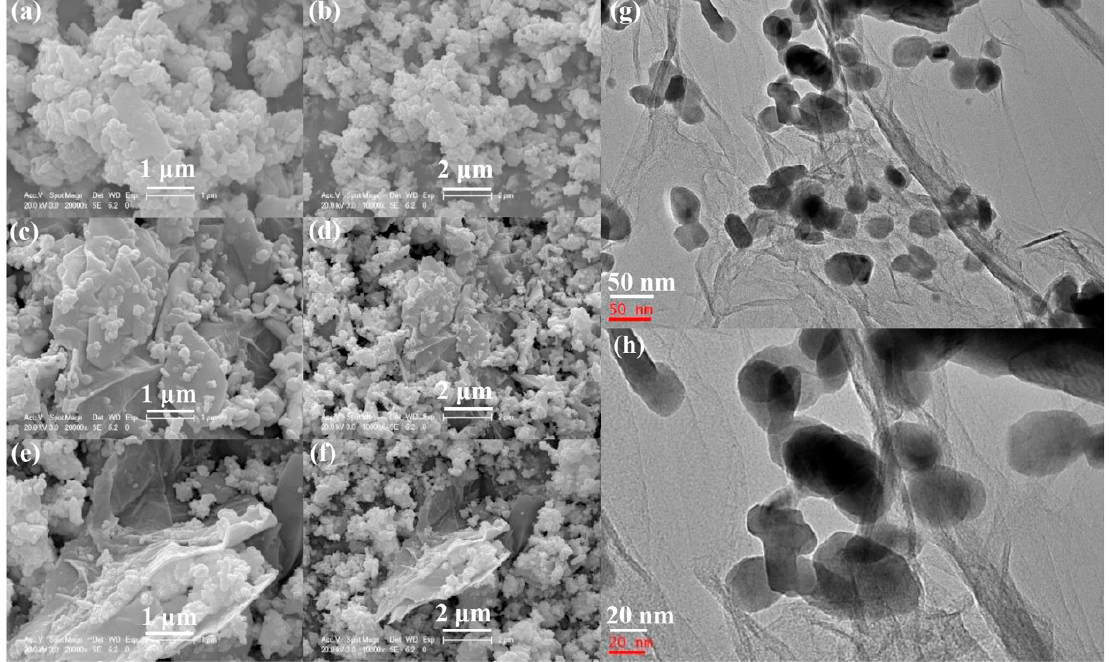
Figure 4. SEM images of rGO/Bi 2 Te 3 nanopowders with ( a , b ) 0.25 wt%; ( c , d ) 0.5 wt%; and ( e , f ) 1 wt% rGO; ( g , h ) TEM images of rGO/Bi 2 Te 3 nanopowders with 1 wt% rGO.